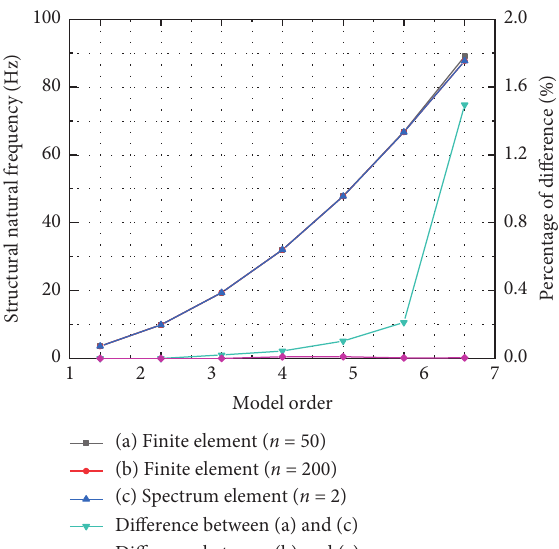
Figure 6: Structural natural frequency and